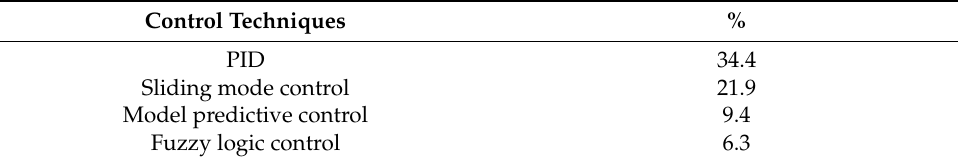
Table 3. Review of control techniques for DAB converters [8].